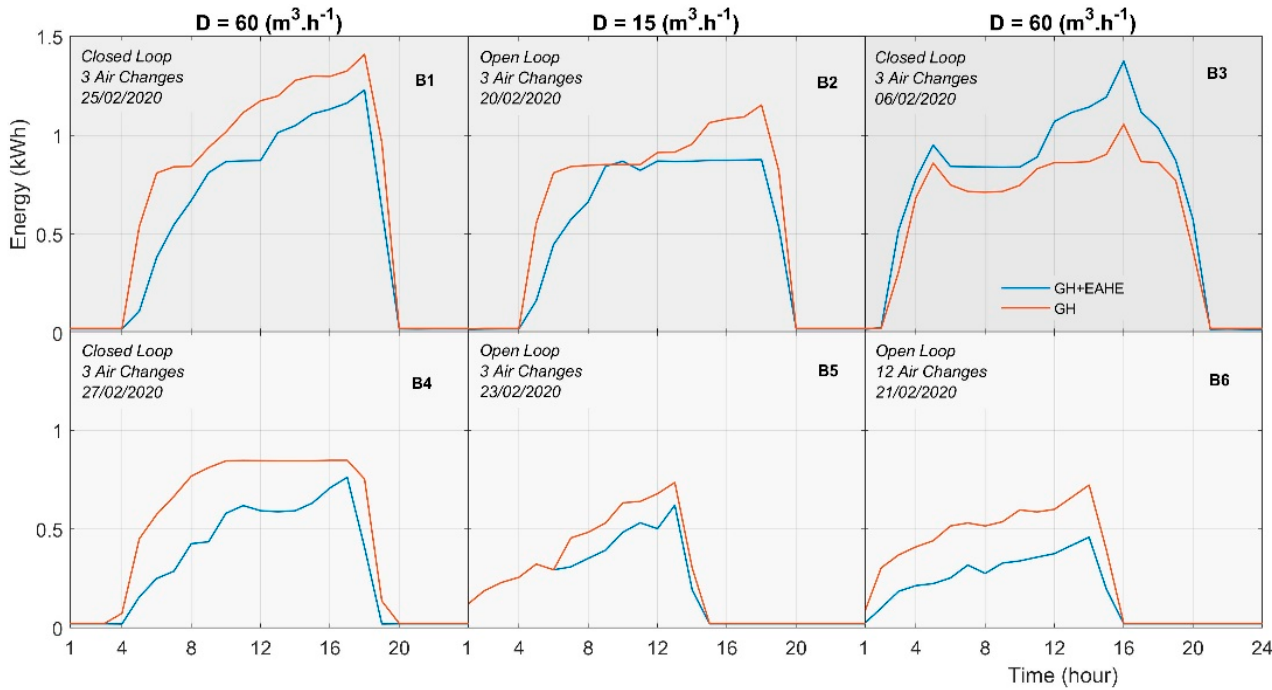
Table 5. Parameter from